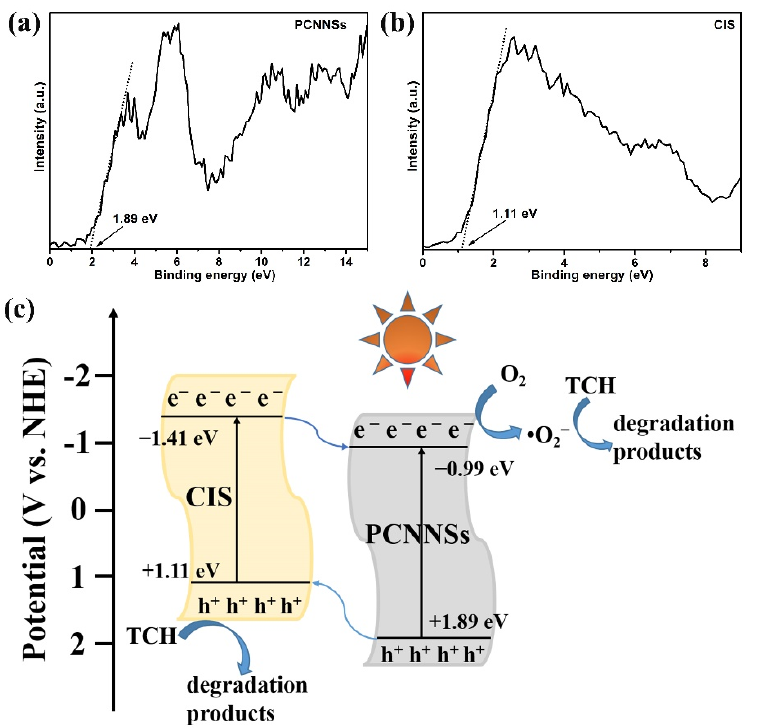
Figure 10. ( a ) VB-XPS of PCNNSs, ( b ) VB-XPS of CIS, and ( c ) schematic diagram of photogenerated charge transfer pathway and possible photocatalytic mechanism in CdIn 2 S 4 /g-C 3 N 4 heterojunction toward TCH degradation.